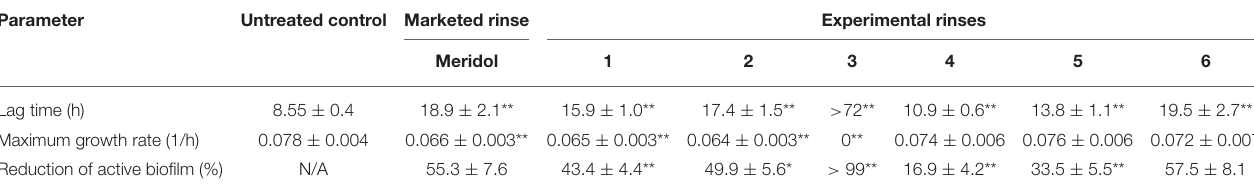
TABLE 2 | Three different parameters were assessed from IMC data: lag time in h, maximum growth rate in 1/h, and reduction in active biofilm in % compared to untreated control biofilm. Parameter Untreated control Marketed rinse Experimental rinses